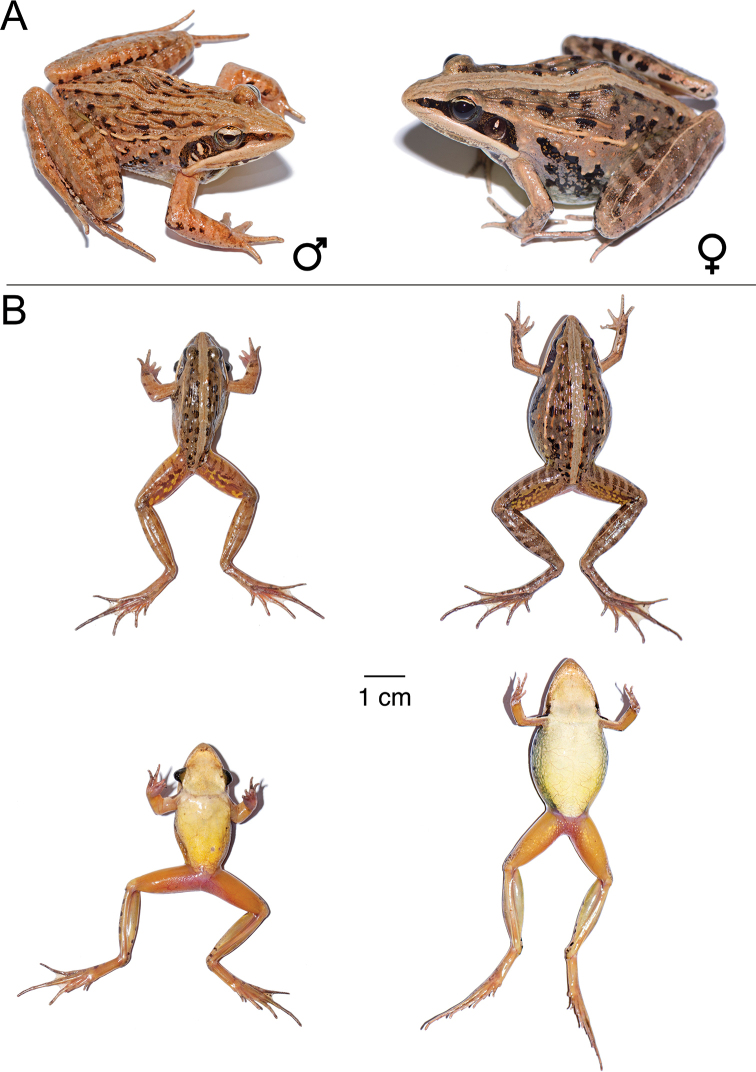
Ptychadena
neumanniA Live male (SB393; left) and female (SB388, right) B dorsal and ventral views of a male (SB333, left) and a female (SB388, right) after euthanasia and before fixation.